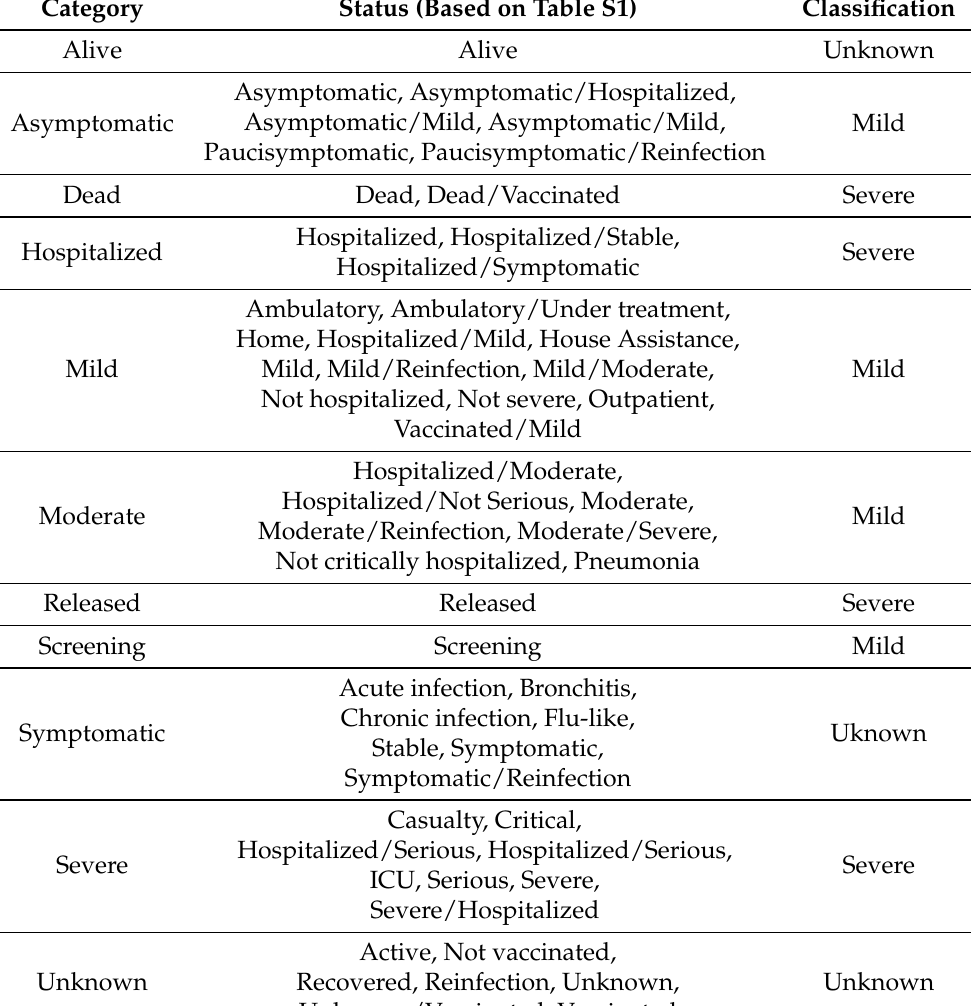
Table 1. Classifications based on metadata entries. Metadata entries are translated to a Status, following the definitions in Supplemental Table S1, and then assigned to Category, which is in turn classified as Mild, Severe, or